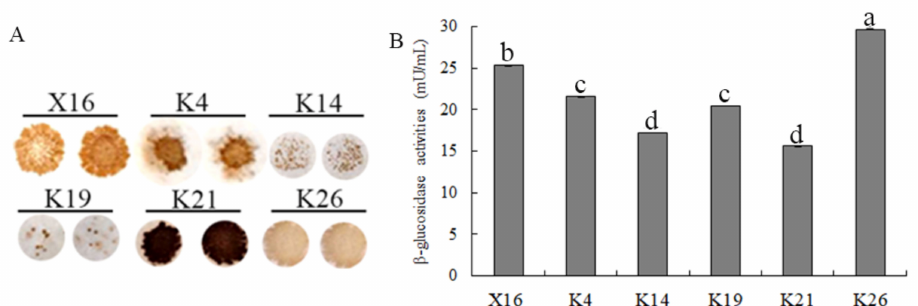
Figure 5. H 2 S and β -glucosidase production capacity of the selected yeasts isolated from KFP. ( A ) H 2 S production capacity and ( B ) β -glucosidase production capacity. Different lowercase letters above the standard deviation bar indicate a significant difference ( p < 0.05).